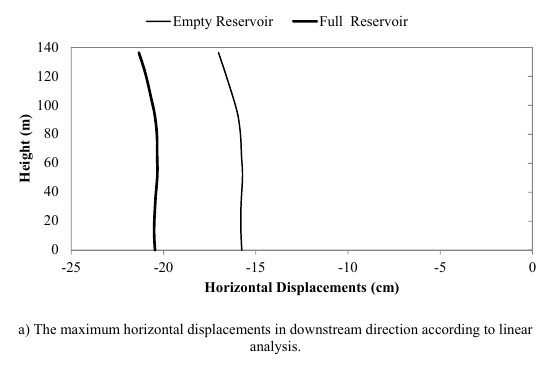
Fig. 16. The horizontal displacement contour diagram of the dam for X Axis in second 10.55.